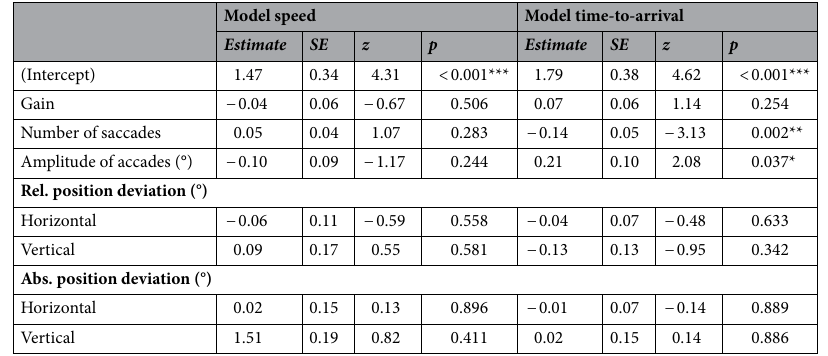
Table 2. Effects of eye movements during the comparison interval on correct discrimination (GLMM analysis). *Significant at p < 0.05. **Significant at p < 0.01. ***Significant at p < 0.001.